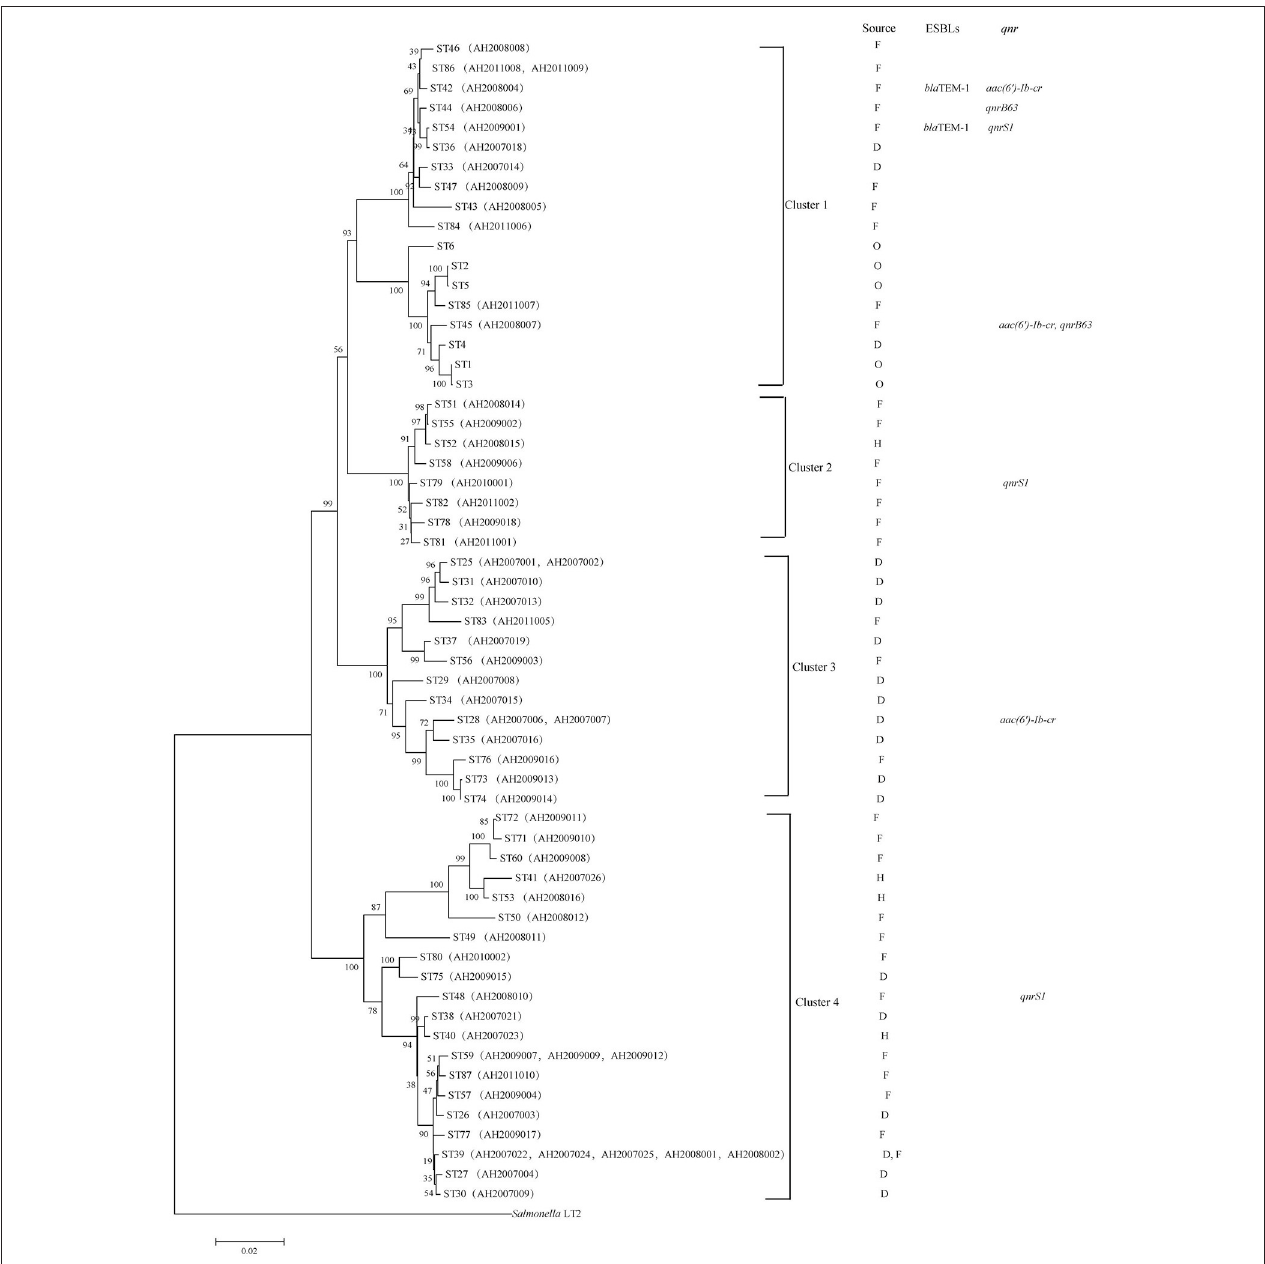
FIGURE 1 | Phylogenetic relationships as determined by MLST data. The presence of ESBLs and qnr genes among the Citrobacter isolates is shown on the right. The tree was constructed using neighbor joining algorithm. For each ST, F, D, H, and O indicate isolates from foods, diarrheal patients, food-handlers and animals respectively. Cluster divisions are marked. Numbers on near the nodes are bootstrap values from 1,000